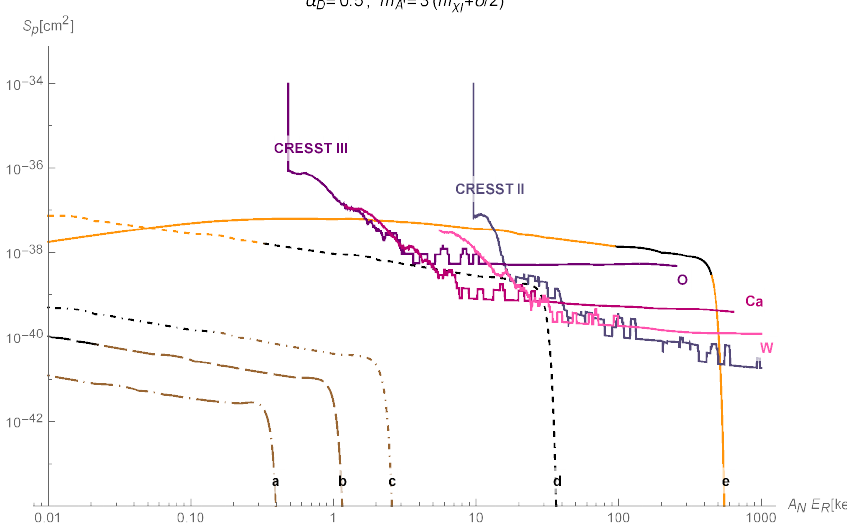
Figure 12 . Sensitivity plot for nuclear recoil searches. The black/brown/orange lines corresponds to the excited DM fraction at the detector times the DM-nucleon cross section over GeV DM for a thermal target. The color scheme and labels of these lines matches that of figure 11. Meanwhile, the solid purple-shaded lines show the sensitivity limits extracted from our own analysis of published datasets from CRESST II and CRESST III, as described in the previous section. For CRESST III, we have separately plotted the sensitivities to scattering off each nucleus, while for CRESST II, to simplify the figure, we show the strongest of the three sensitivities at each x -axis value. Analogous plots for additional dark-sector benchmarks are shown in figure